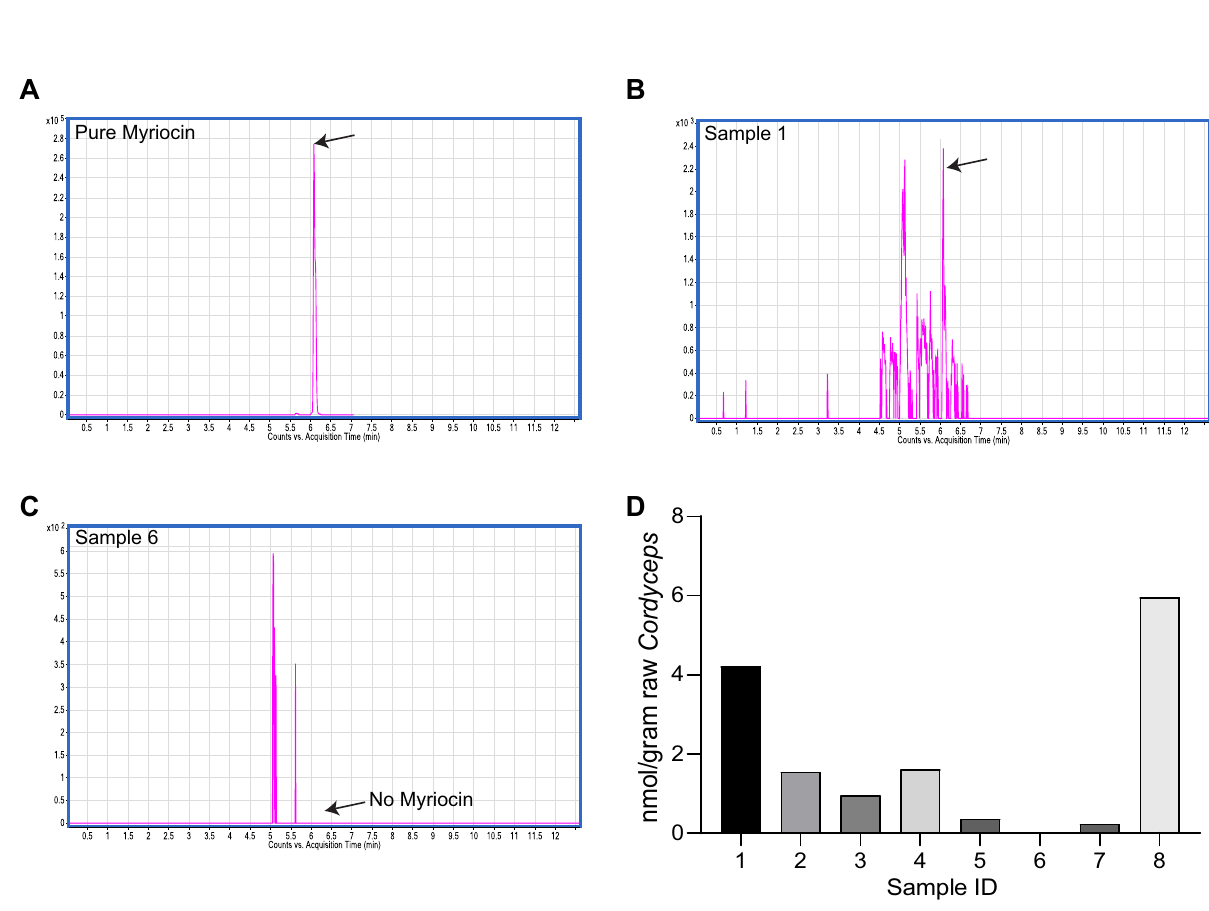
Figure 1. Screening of Cordyceps extracts for myriocin content via mass-spectrometry. ( A ) LC/MS chromatogram of purified myriocin and Cordyceps Sample 1 ( B ) and Sample 6 ( C ) depicting myriocin content. ( D ) Quantification of myriocin content in Samples 1–8 as determined by